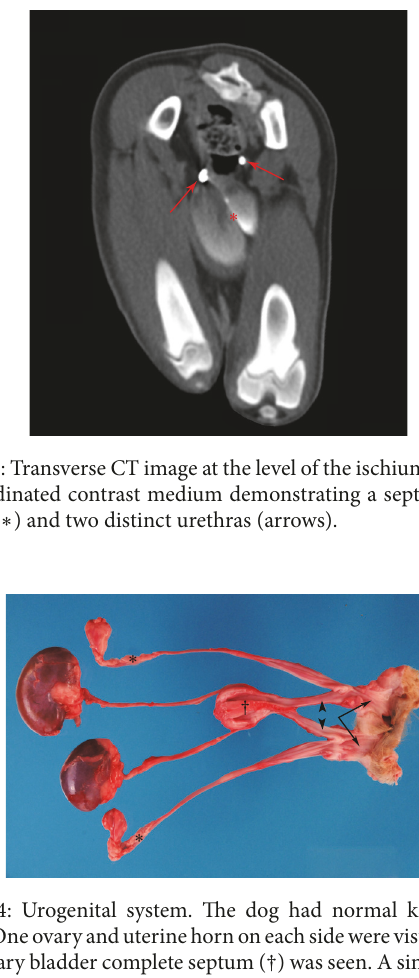
Figure 4: Urogenital system. The dog had normal kidneys and ureters.Oneovaryanduterinehornoneachsidewerevisualized( ∗ ). The urinary bladder complete septum ( † ) was seen. A single urethra (arrowheads) exiting on each side of the urinary bladder and then joining each cervix before exiting through separate vaginal canals